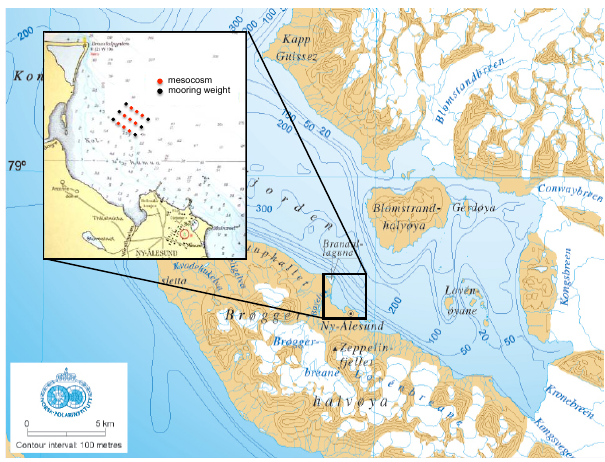
Fig. 10. Map of Kongsfjorden on the north-west coast of Svalbard. Insert shows the study area with the location and orientation of the mesocosm array. Source of map: Norsk